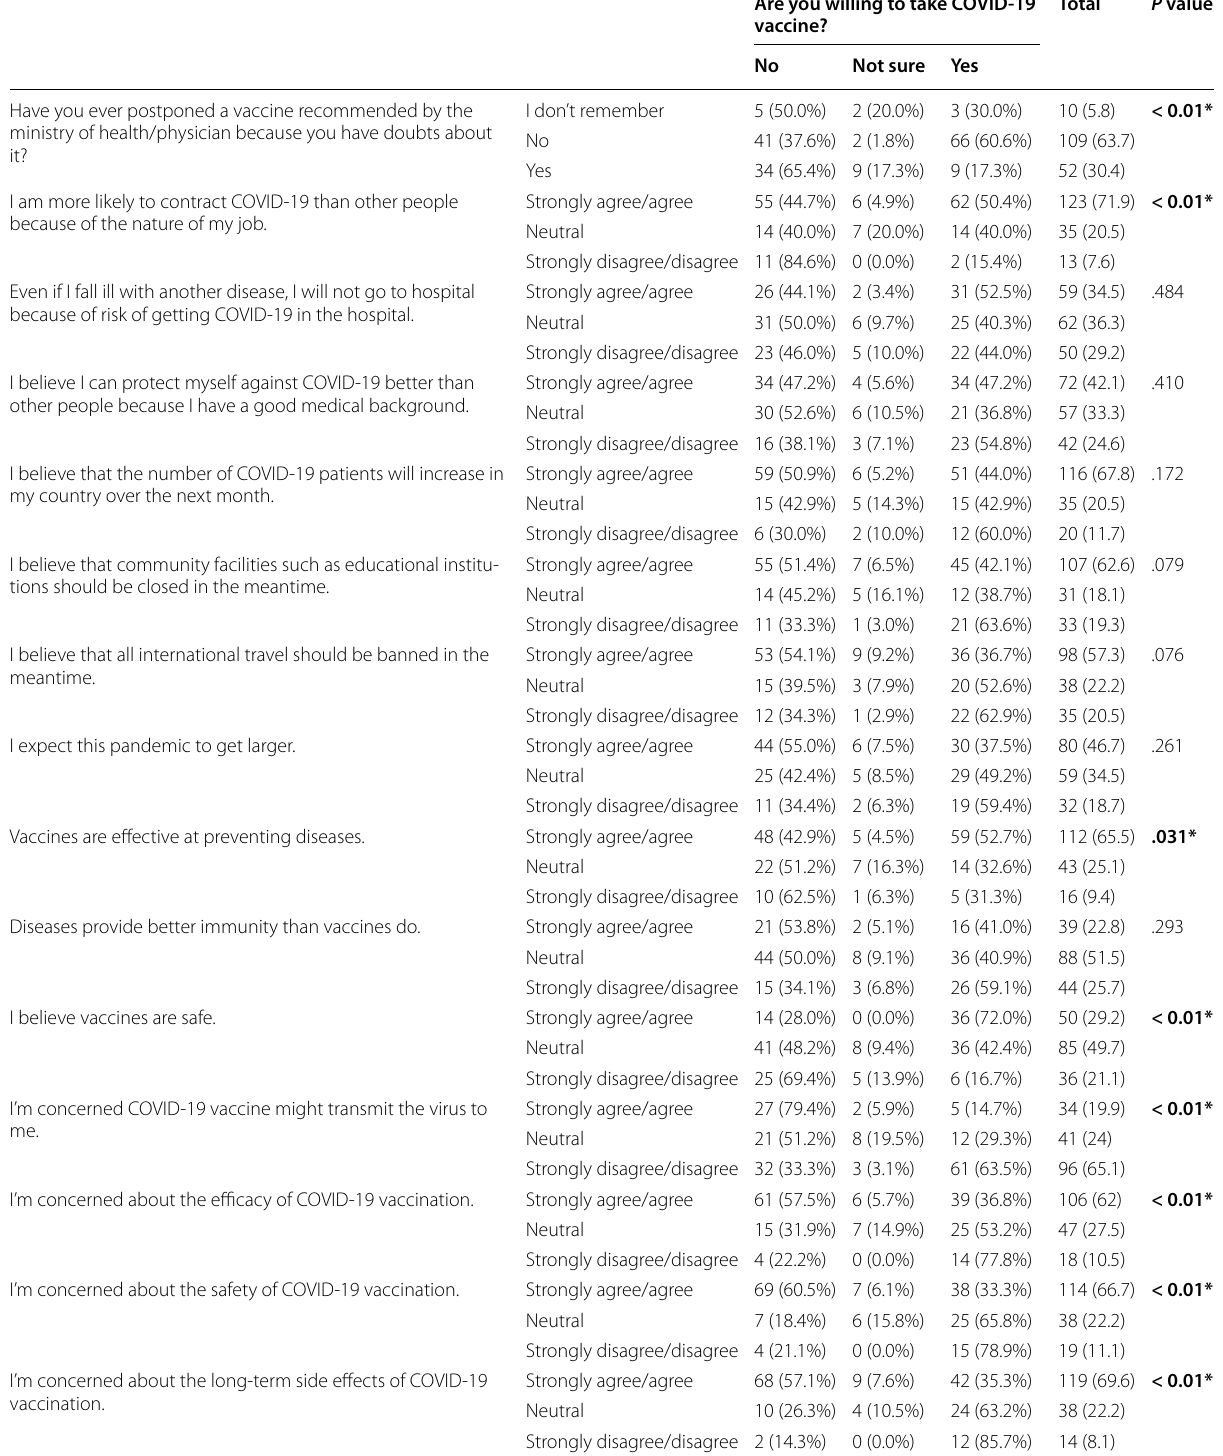
Table 2 Beliefs of the vaccine accepting, vaccine refusing, and vaccine hesitant dental teaching staff of Faculty of Dentistry, Ain Shams University, Egypt ( N =